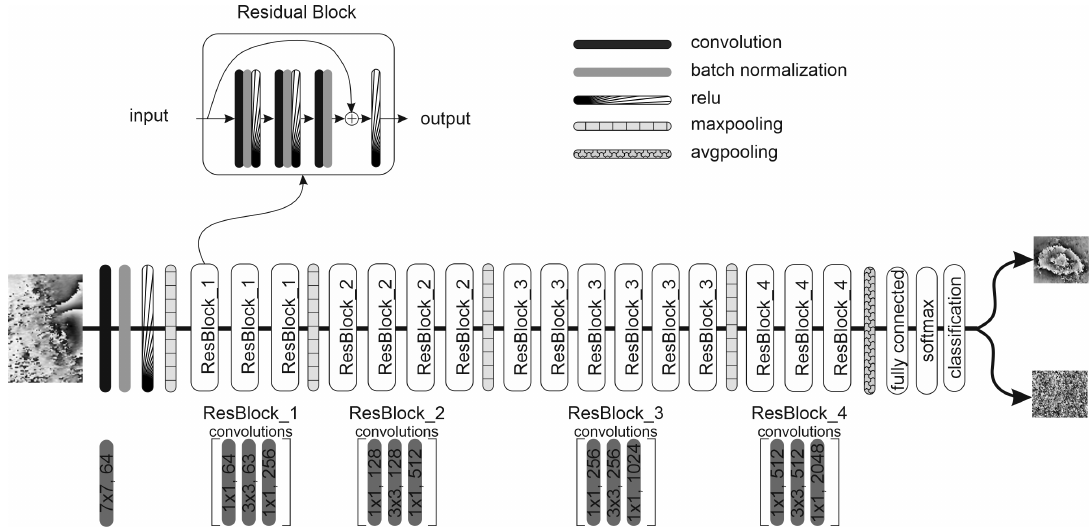
Figure 5. Residual network architecture applied in our